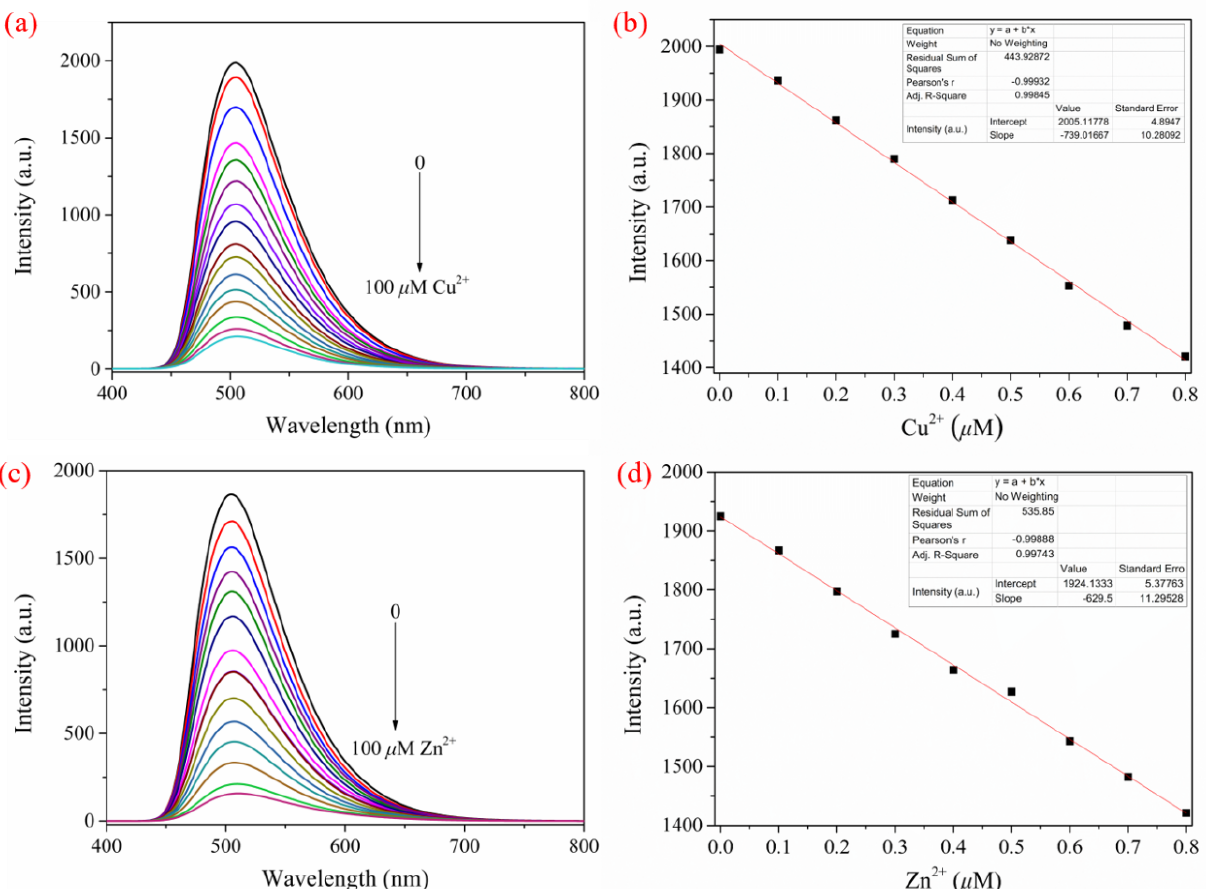
Figure 5. Fluorescence titration of CPBI 2 (1 mg/15 mL in DMSO/H 2 O, v / v , 9/1) solution with Cu 2+ ( a , b ), Zn 2+ ( c , d ), and their corresponding detection limits (λ ex = 375 nm).